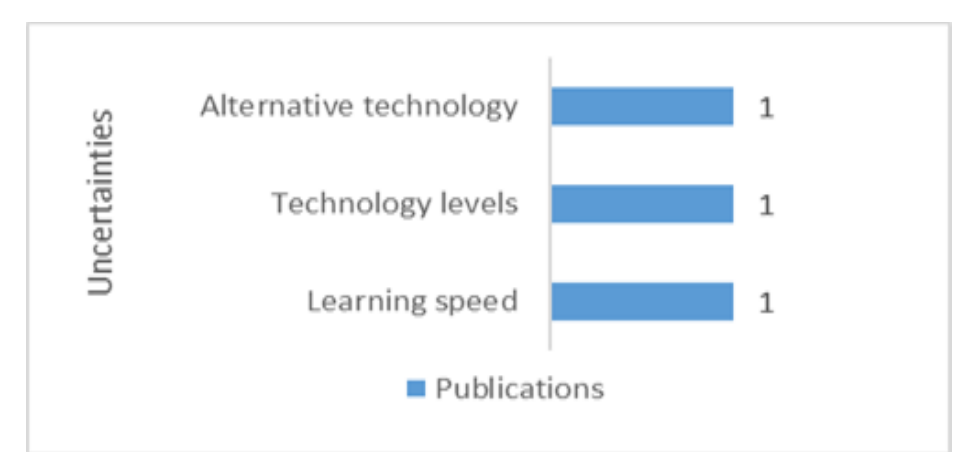
Figure 11. Technological progress.